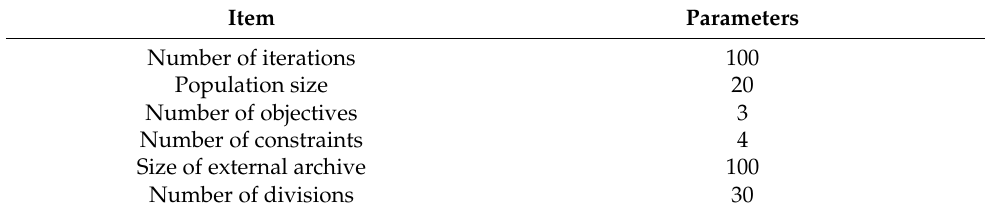
Table 3. Parameters of the proposed MOPSO algorithm.